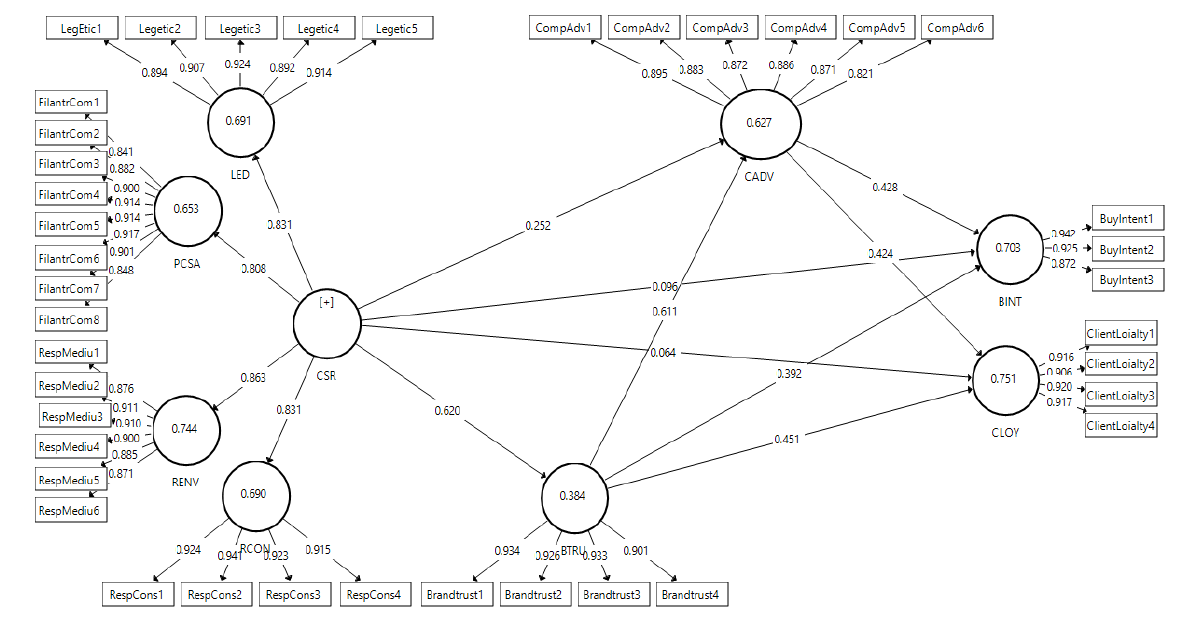
Figure 2. Structural model. Source: Authors computation with SmartPLS 3.3.3 [70]. Table 6. Testing for direct effects.